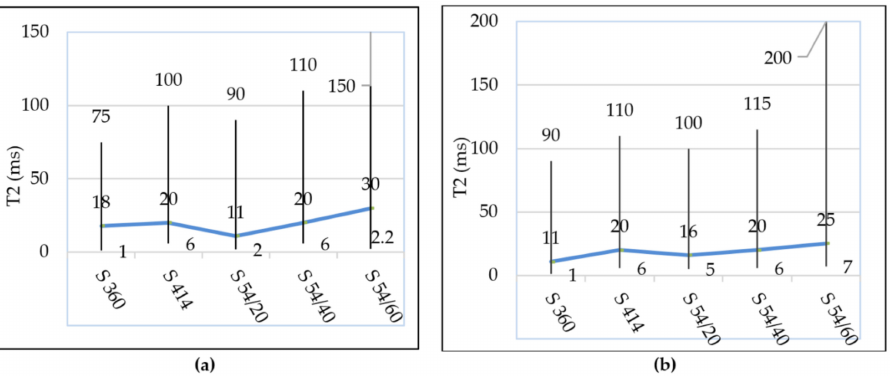
Figure 9. The capillary pores distribution range: ( a ) for the control samples (w); ( b ) for the samples tested in freeze–thaw (f-t). Both measurements were made on cyclohexane-saturated